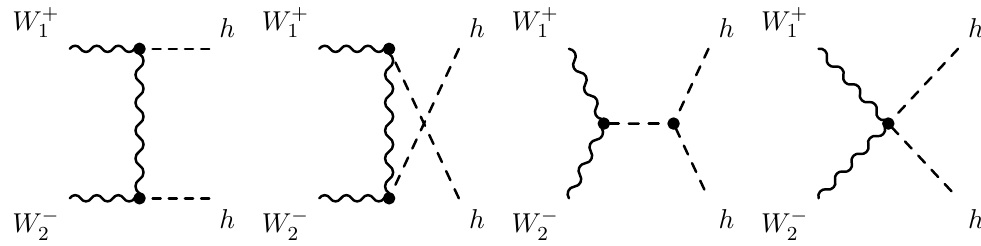
Figure 5 . Factorizable and contact-term contributions to the LE W + W − hh